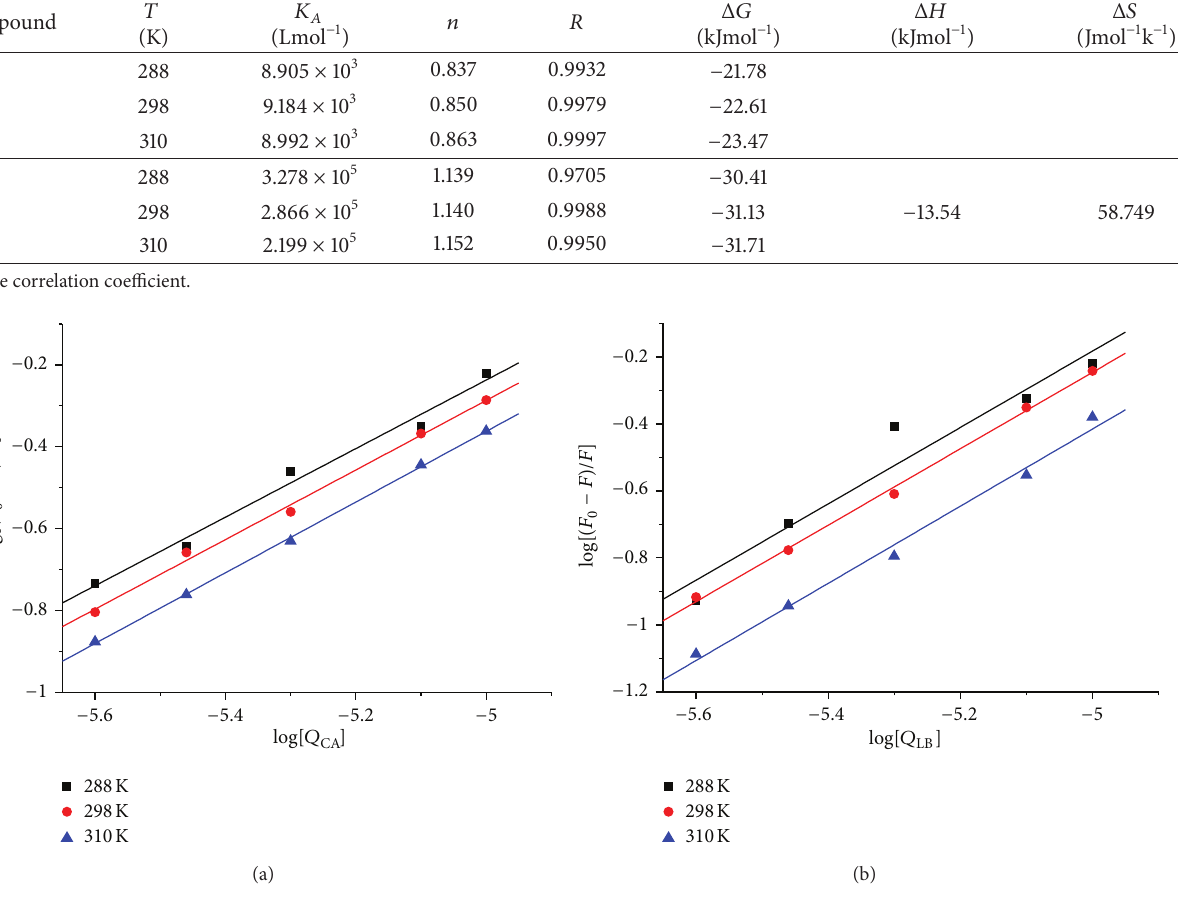
Figure 4: Plots of log [(𝐹 0 − 𝐹)/𝐹] versus log [𝑄